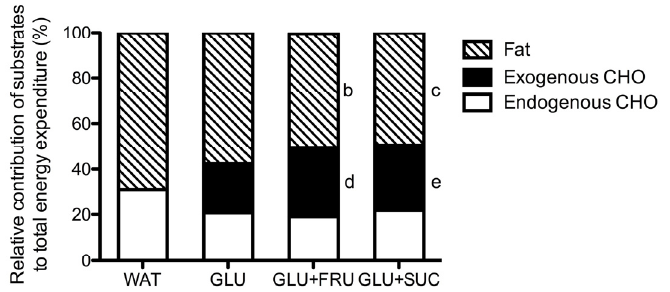
Figure 2. Relative contribution of substrates to total energy expenditure calculated for the 60 ‐ to 180 min period of exercise without the ingestion of carbohydrate (WAT), with the ingestion of glucose (GLU), with the ingestion of glucose and fructose (GLU + FRU), or with the ingestion of glucose and sucrose (GLU + SUC). Data were analsysed with a repeated measures ANOVA (treatment). Data are presented as means ± SEM. N = 10; b, denotes GLU + FRU significantly different from WAT; c, denotes GLU + SUC significantly different from WAT; d, denotes GLU + FRU significantly different from GLU; e, denotes GLU + SUC significantly different from GLU ( p < 0.05).